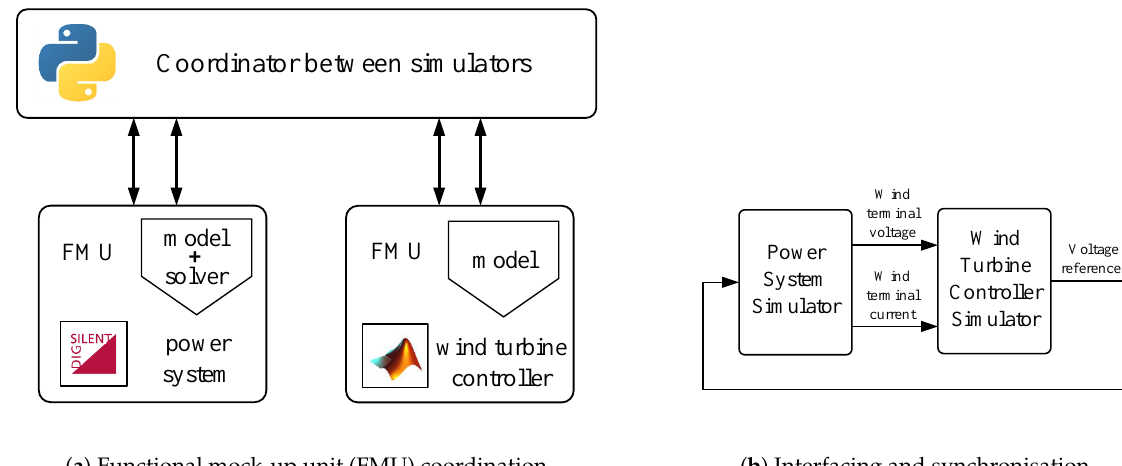
Figure 6. Overview of the functional mock-up interface (FMI)-based co-simulation using Python code to